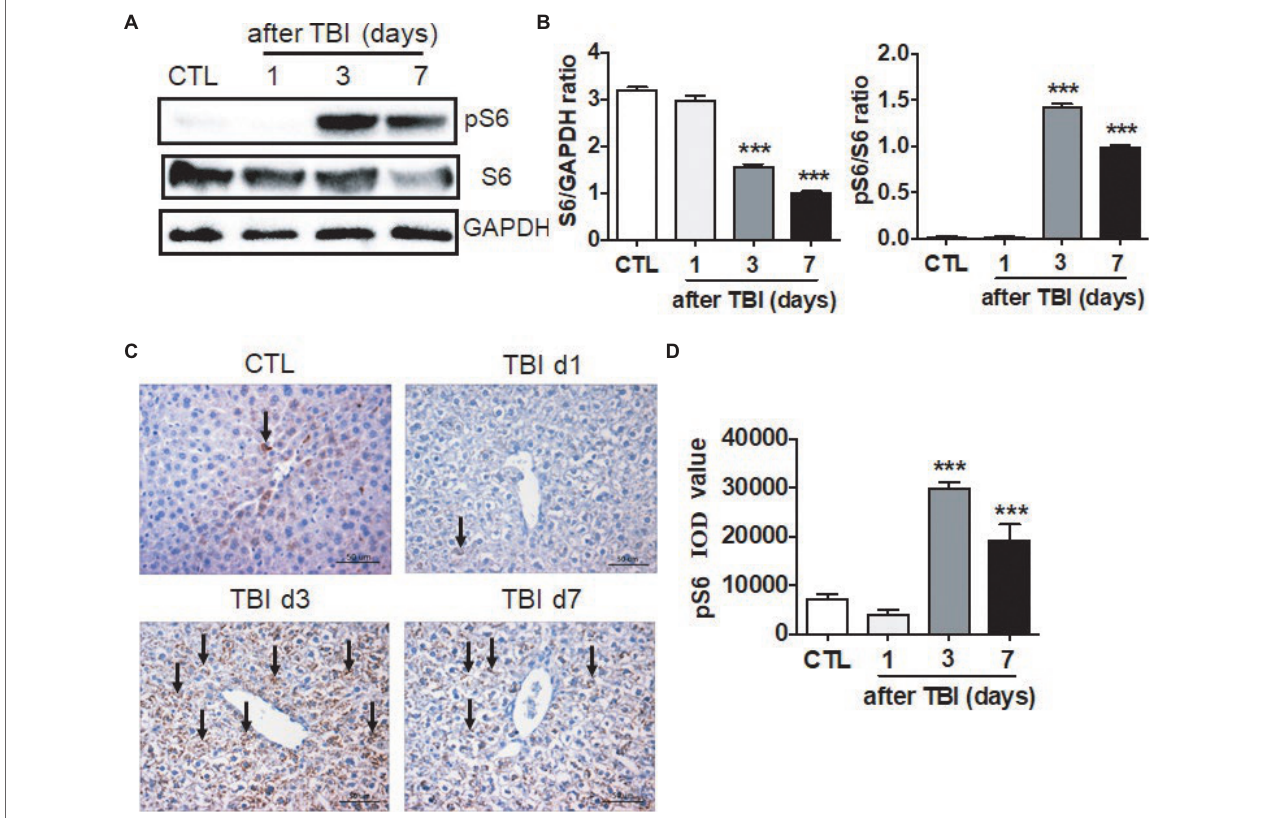
FIGURE 3 | mTORC1 signaling was activated by irradiation in liver tissues. (A and B) Expression of pS6 was upregulated post-irradiation in liver tissues. Expression of pS6 and S6 (A) was detected by western blotting at days 1, 3, and 7 after irradiation ( n = 3). GAPDH was used as a housekeeping control. Expression of pS6 and S6 (B) was quantitated by ImageJ software. (C and D) pS6 immunostaining in liver tissues ( n = 6). Liver tissues were fixed in 4% paraformaldehyde after irradiation and pS6 immunostaining was performed as indicated in materials and methods (C) . Scale bar = 50 μ m. Arrows indicate pS6 positive cells. Imaging software was used to analyze the integrated optical density (IOD) of pS6 (D). *** p < 0.001 vs.